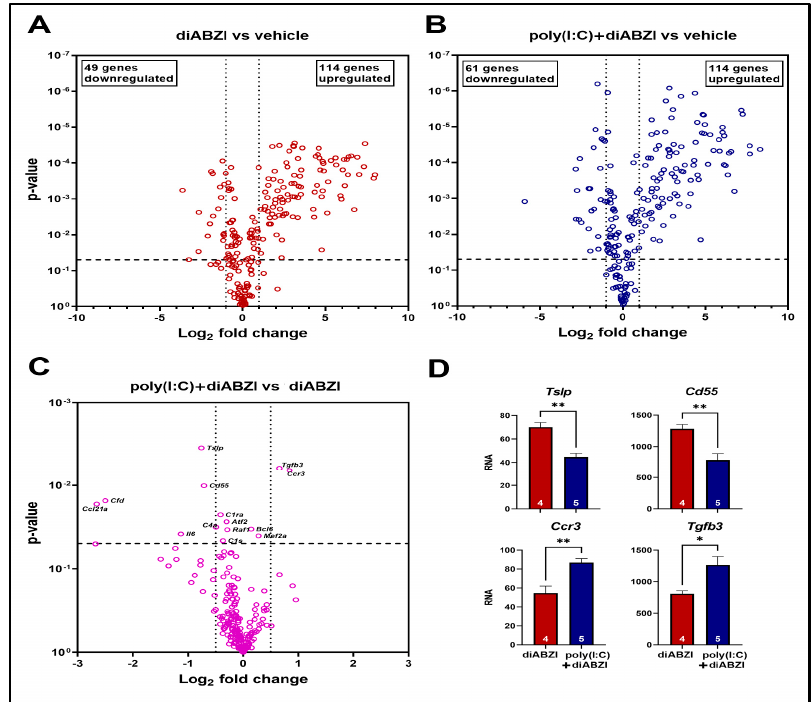
Figure 5. Volcano plots showing differential gene expression from skin harvested on day 8 comparing ( A ) diABZI-treated ( n = 4) with vehicle-treated ( n = 3) mice, ( B ) poly (I:C)+diABZI-treated ( n = 5) with vehicle-treated ( n = 3), and ( C ) poly (I:C)+diABZI-treated ( n = 5) with diABZI-treated ( n = 4) mice. The 13 DE genes are labeled, and the expression values for the 4 most significant DE genes are shown in panel ( D ). * p < 0.05; ** p < 0.01.